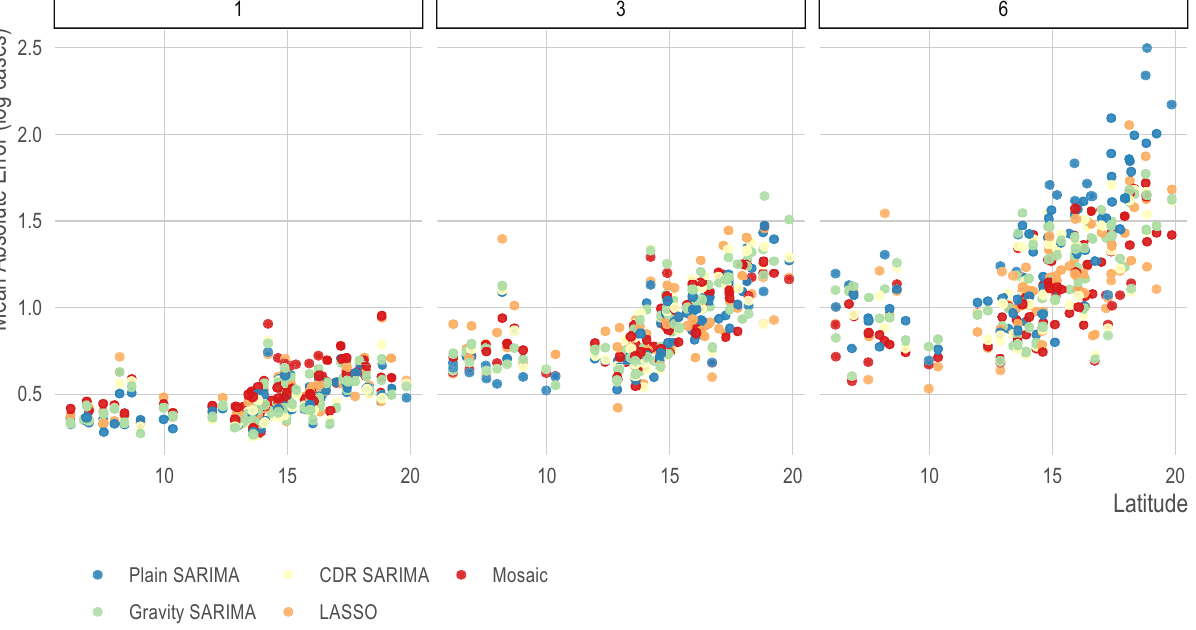
Figure 3. Mean absolute error for the best model in each class at t + 1, t + 3, and t + 6 forecasting horizons for all provinces. The mean absolute error (y-axis) on the prediction (i.e., log) scale of the best model for each class for all provinces (x-axis). Provinces are ordered by latitude (x-axis, right is more northerly). There is a general decline in predictive power at farther forecasting horizons and at more northerly provinces; however, no single model or class of model performs best across all areas and all prediction